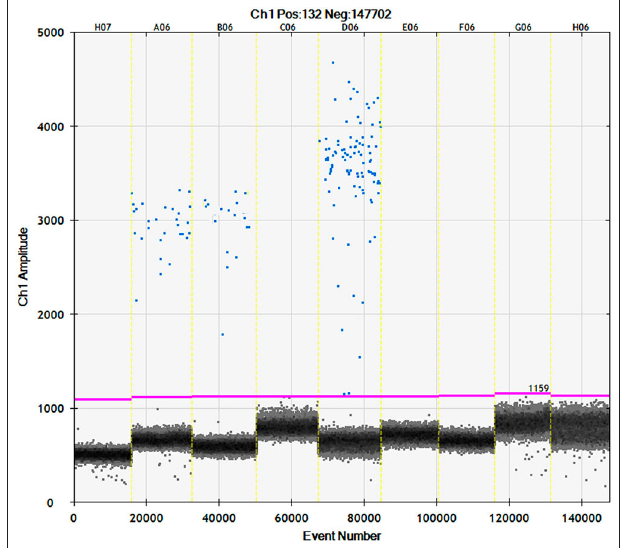
FIGURE 4 | Channel 1 results for droplet separation based on simplex assays. Droplet separation based the IS 6110 simplex assay results. Positive droplets were observed at an amplitude of about 3,000 while negative droplets were observed at an amplitude of about 1,100.